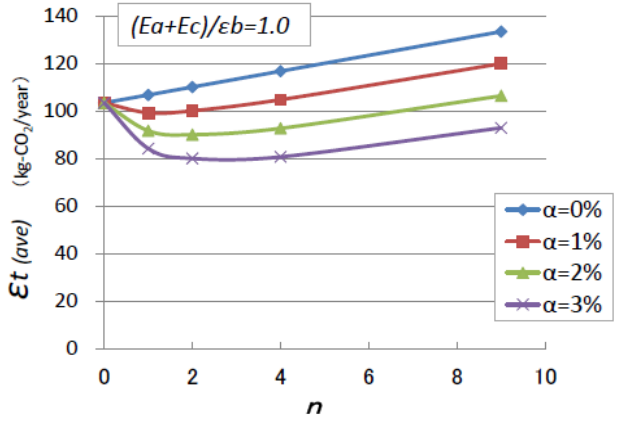
Figure 9. Relationship between ε t and n.